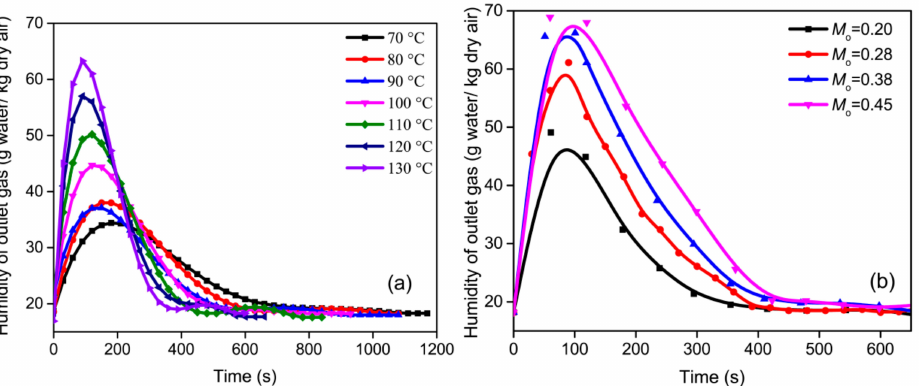
Figure 4. The humidity of outlet air during the drying process: ( a ) for different drying temperatures; ( b ) for different initial moisture